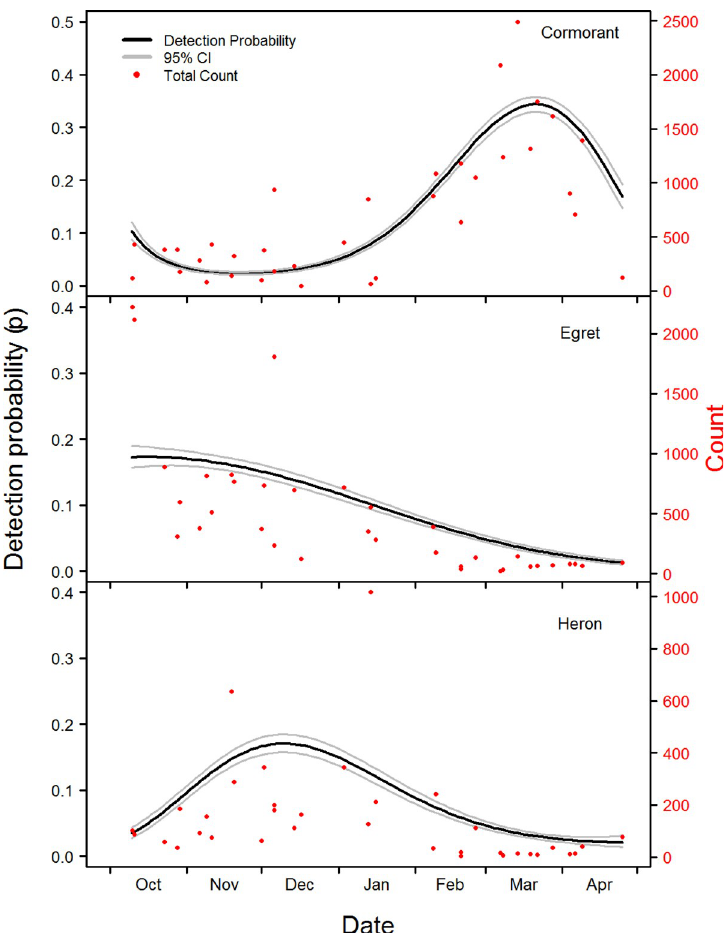
Fig 2. Detection probabilities (+ 95% CI) as a function of date for cormorants, egrets, and herons, estimated from occupancy analysis of catfish pond in the Mississippi Delta. Data used for analysis were collected using aerial surveys of catfish ponds, approximately every two weeks from October–April of 2015, 2016, and 2017. Total count of each survey for each species is displayed in red.